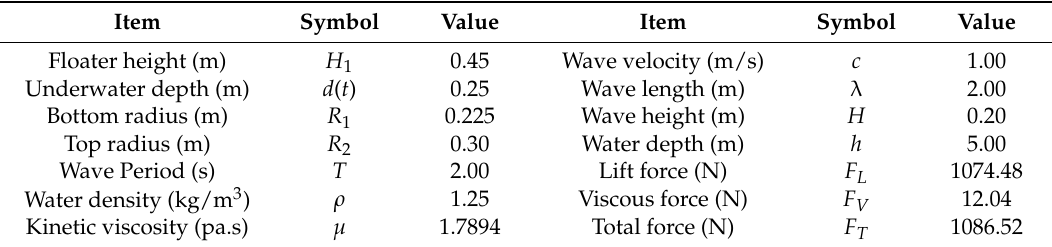
Figure 3. Fluid volume fraction and pressure distributions of the cone frustum floater: contours of ( a ) volume fraction (water) and ( b ) static pressure. Table 1. Parameters of the cone